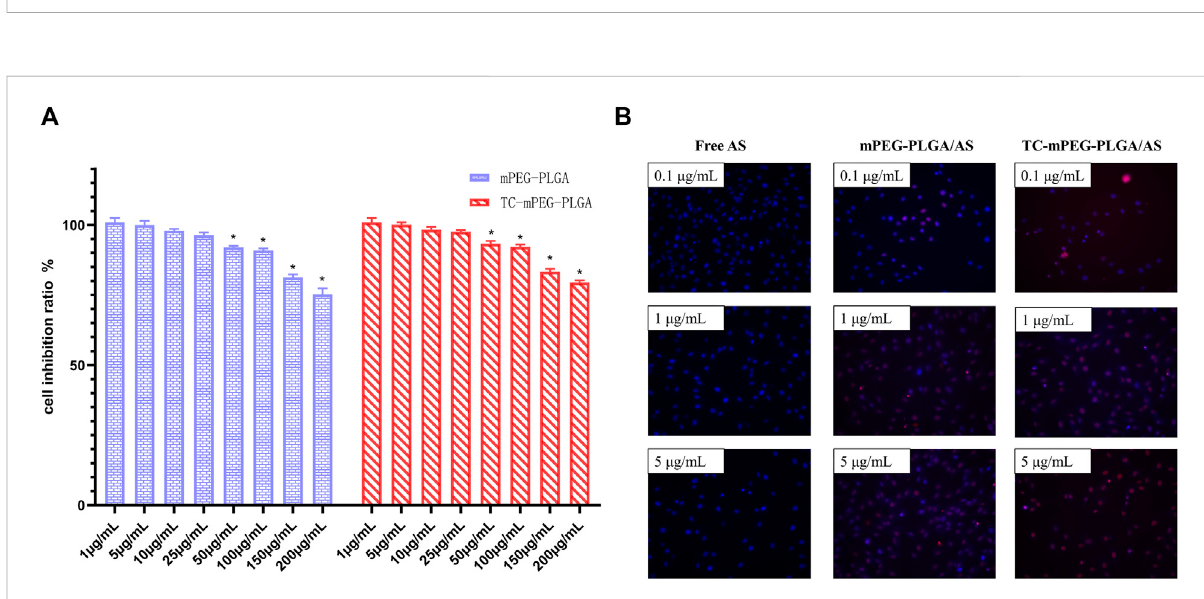
FIGURE 2 TEM images (A) (a, mPEG ‒ PLGA micelles; b, AS-loaded mPEG ‒ PLGA micelles; c, TC grafted mPEG ‒ PLGA micelles; d, AS-loaded TC grafted mPEG ‒ PLGA micelles) and in vitro release behavior in PBS (B) . TEM, transmission electron microscopy; AS, astragaloside IV; TC, tetracycline; PBS, phosphate-buffered